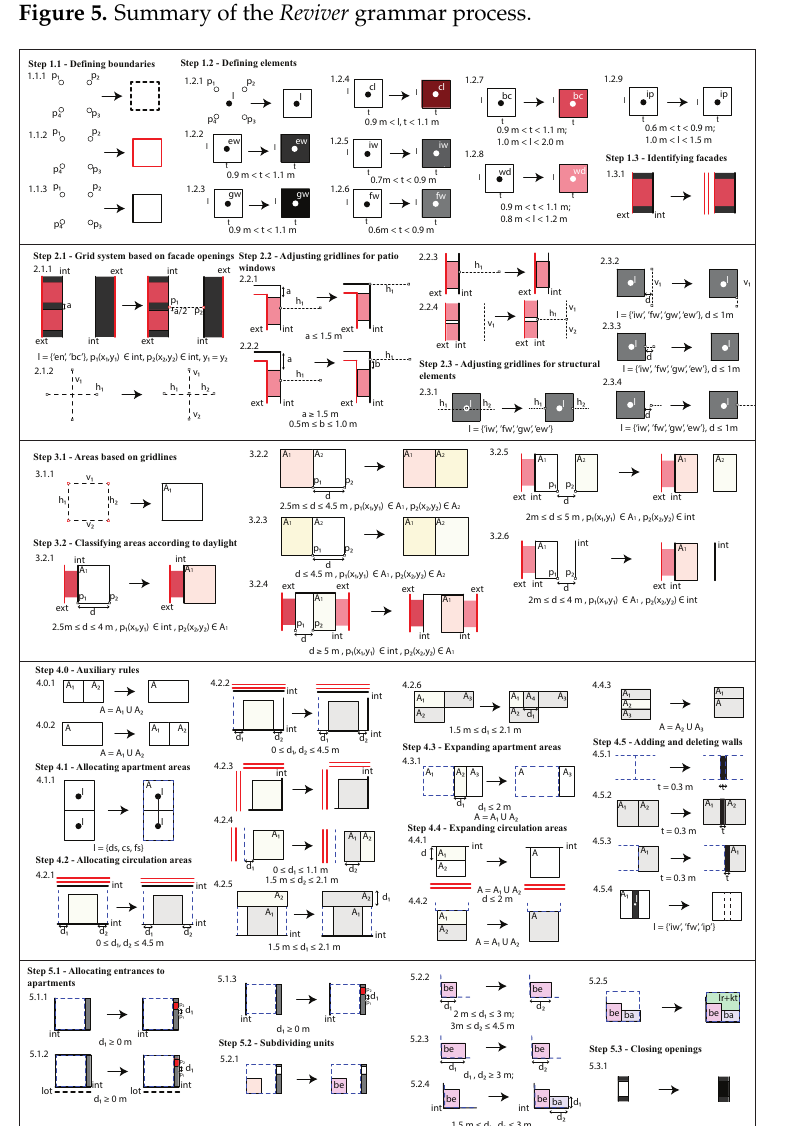
Figure 6. Ruleset for the Reviver